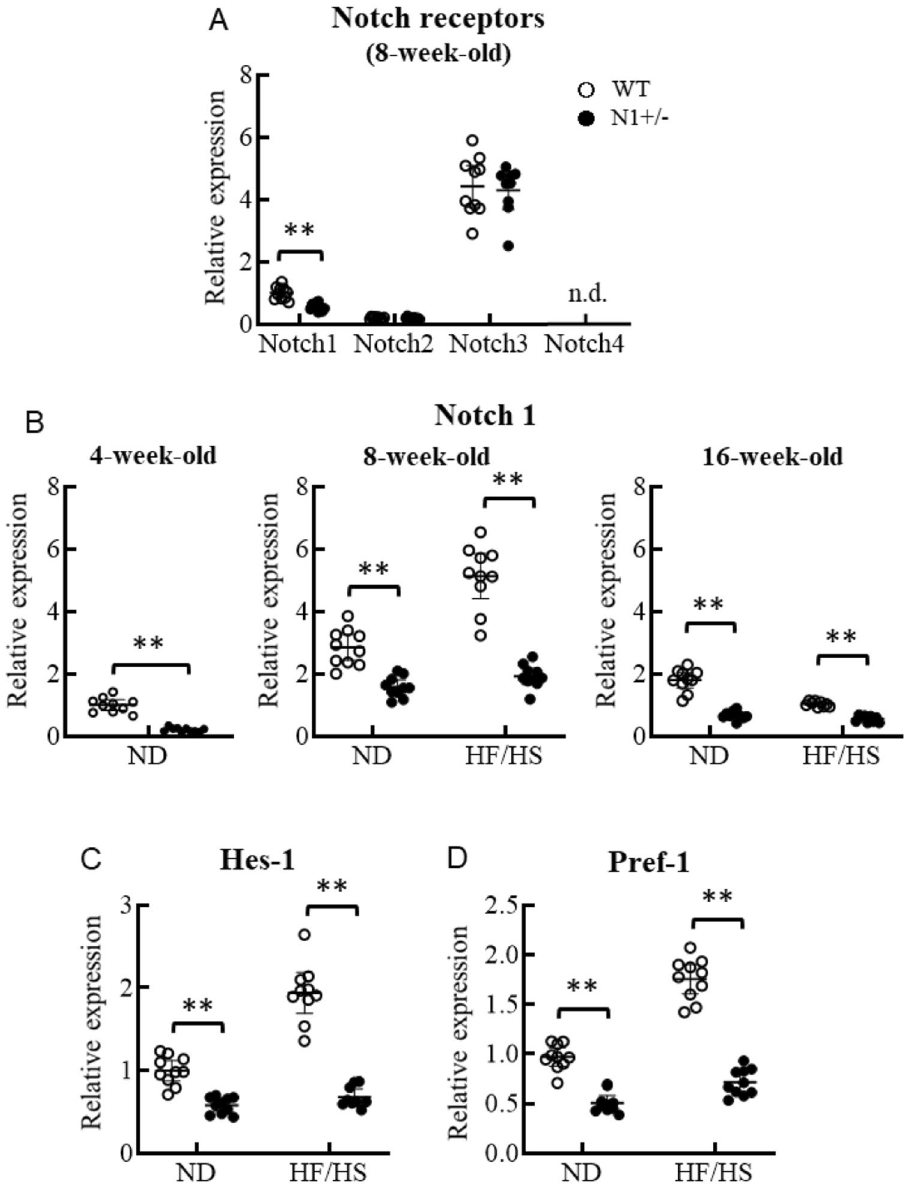
Figure 3. Notch1 haploinsufficiency increases adipogenic transcriptional factors in white adipose tissue. Notch1 expression in adipose tissue was decreased by as much as 50% in N1+/− mice. Notch1 expression in adipose tissue reached a peak value in 8-week-old mice in parallel with fat accumulation especially under HF/HS-fed condition, but such increase was blunted in N1+/− mice. The expression levels of Hes-1 and Pref-1, and Sox9 were decreased in adipose tissues of N1+/− mice. Downregulation of Sox9 enhanced the expression of the master activators of adipogenesis, PPARγ and C/EBPα. ( A ) Quantitative analysis of Notch1, Notch2, Notch3, and Notch4 mRNA expression levels in adipose tissues of 8-week-old WT and N1+/− mice. ( B ) Quantitative analysis of Notch1 mRNA expression levels in adipose tissues of 4-, 8-, and 16-week-old mice. ( C – G ) Quantitative analysis of mRNA expression levels of Hes-1 ( C ), Pref-1 ( D ), Sox9 ( E ), PPARγ ( F ), and C/EBPα ( G ) in adipose tissues of 8-week-old mice. ( H ) Immunoblotting showing cleaved-Notch1 in adipose tissues of 4-week-old mice. Representative western blot of fractionated samples. The cropped blots are used in the figure. The membranes were cut prior to exposure so that only the portion of gel containing the desired bands would be visualized. The samples of fractionation derive from the same experiment and the blots were processed in parallel. Full-length blots are shown in Supplementary information (Page 6). Quantification of western blot bands. Protein expression was normalized to β-actin. ( I ) Immunoblotting showing cleaved-Notch1 and Pref-1 in adipose tissues of 8-week-old mice. Representative western blot of fractionated samples. The cropped blots are used in the figure. The membranes were cut prior to exposure so that only the portion of gel containing the desired bands would be visualized. The samples of fractionation derive from the same experiment and the blots were processed in parallel. Full-length blots are shown in Supplementary information (Page 6). Quantification of western blot bands. Protein expression was normalized to β-actin. Data are mean ± SD. **P < 0.01, compared with WT mice. n = 8–10 per group ( A – G ), n = 5 per group ( H and I